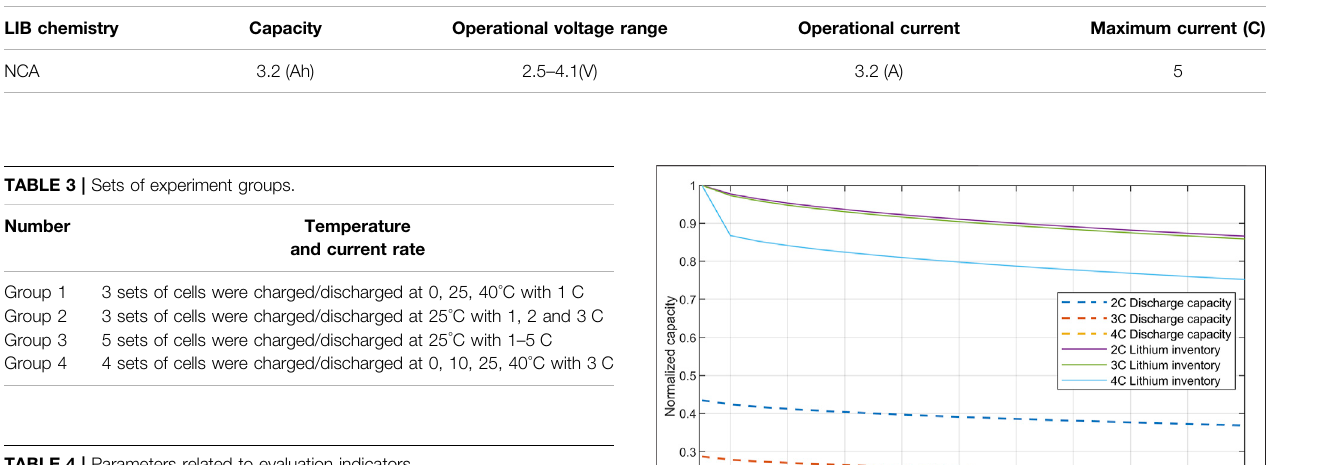
TABLE 2 | Basic parameters of battery.